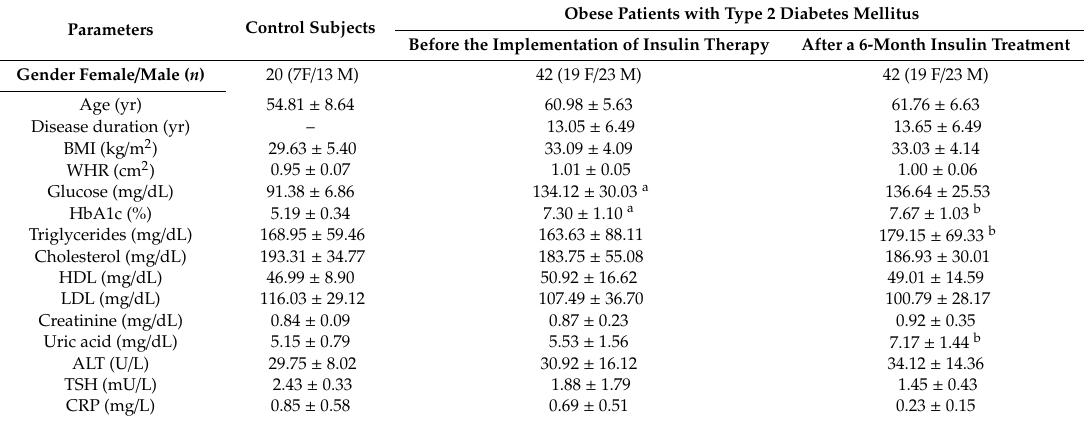
Table 1. Clinical characteristics of control subjects and obese patients with type 2 diabetes